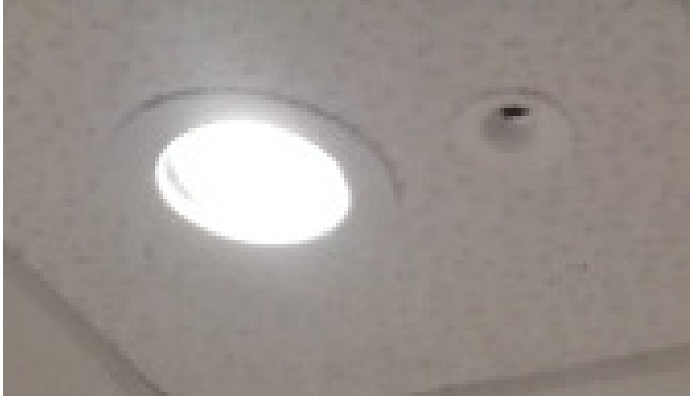
Figure 3. LED lamp and IR sensor mounted on the